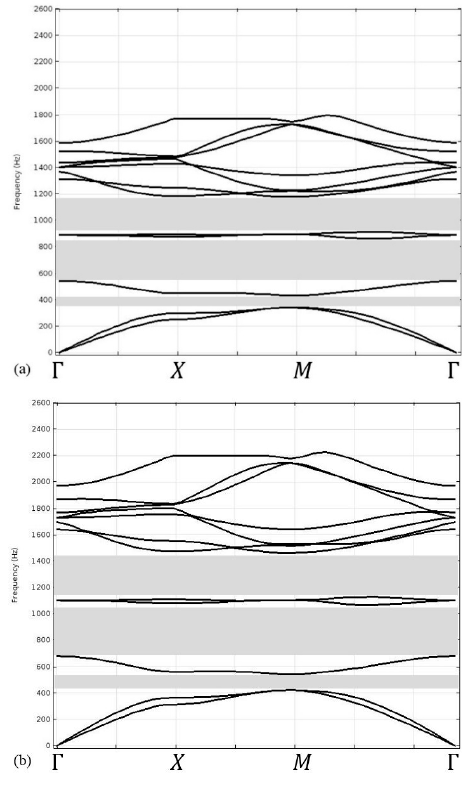
Figure 1. The illustration of phononic crystal. Two cross sections of the inclusions are considered. They are ( a ) circular cross section and ( b ) rectangular cross section.